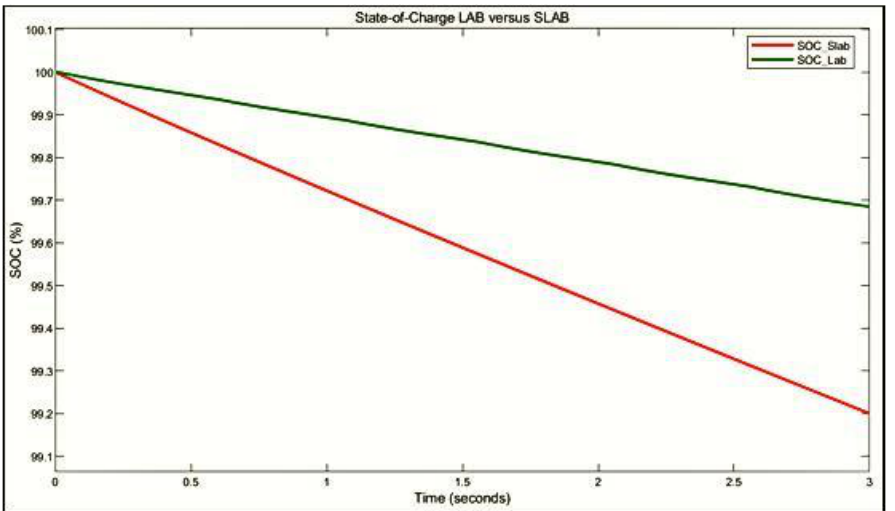
Figure 23. The SoC of the LAB in a HESS versus SLAB during discharging mode for case three.